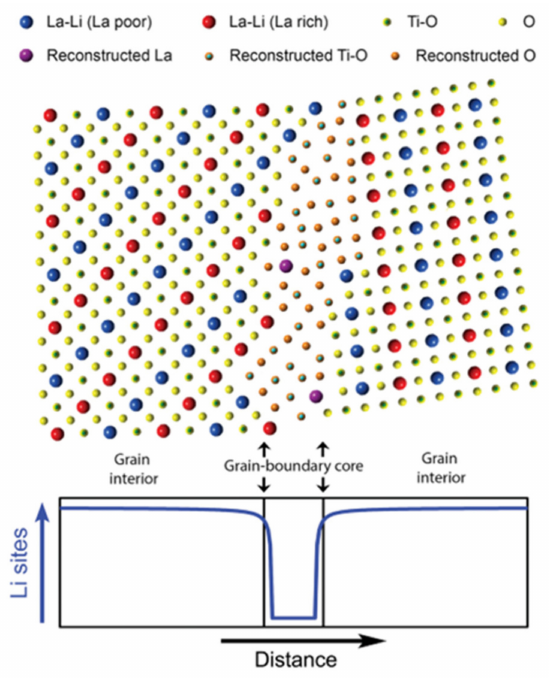
Figure 37. Schematic of the atomic configuration of the type I GB based on the HAADF-STEM images and EELS analysis, along with an illustration of the Li site distribution across type I GB [20]. Reproduced from [20] with permission from the Royal Society of Chemistry, Copyright